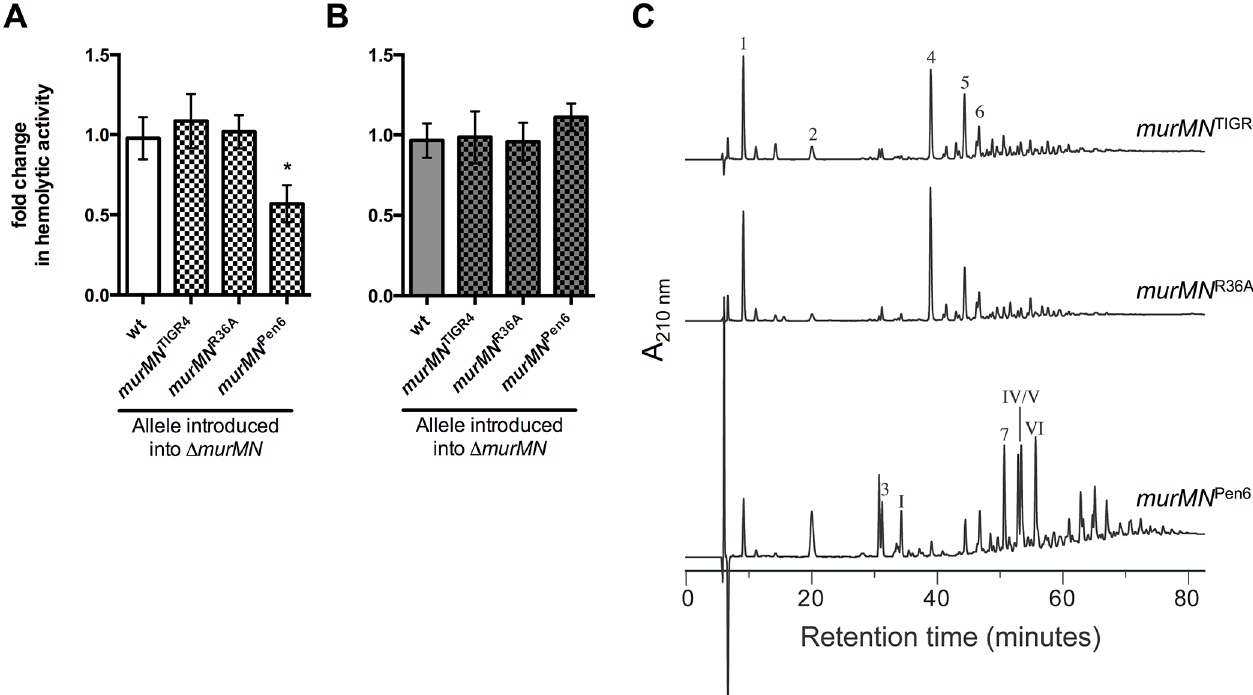
Fig 4. Increased Ply release observed upon murMN deletion can be differentially restored by variant murMN alleles. Hemolytic activity of whole cells (A) or sonicated lysates (B) of marked Δ murMN strains expressing the murMN operon from wt ( murMN TIGR4 ), R36A ( murMN R36A ) or Pen6 ( murMN Pen6 ). The wt chromosomal murMN promoter controls expression of each allele. Data are presented as the mean fold change in hemolytic activity compared to the wt in each condition ± SEM of at least four biological replicates. * p < 0.05, Student ’ s t-test. (C) RP-HPLC analysis of the stem peptides from purified PG isolated from each of the repaired strains. See Materials and Methods for a description of the procedures for PG purification, separation of stem peptides, and analysis. Peptides were detected by their absorption at 210 nm and the chemical structures of assigned peaks are diagrammed in S4